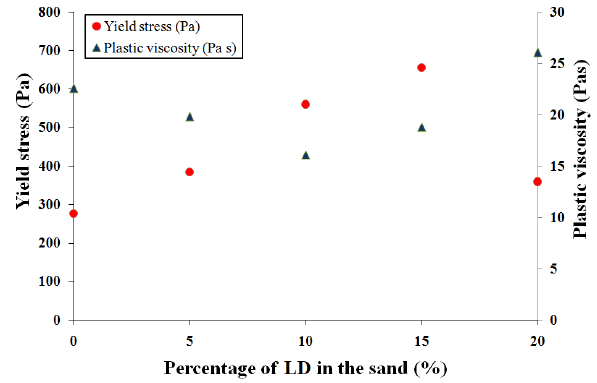
Figure 11: Effect of LF content in the CS on the evolution of the